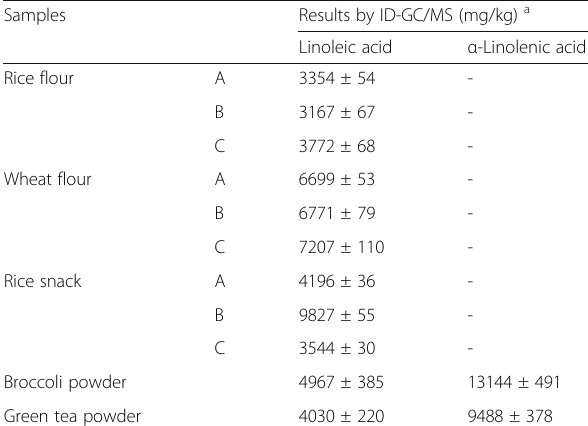
Table 3 Linoleic acid and α -linolenic acid contents